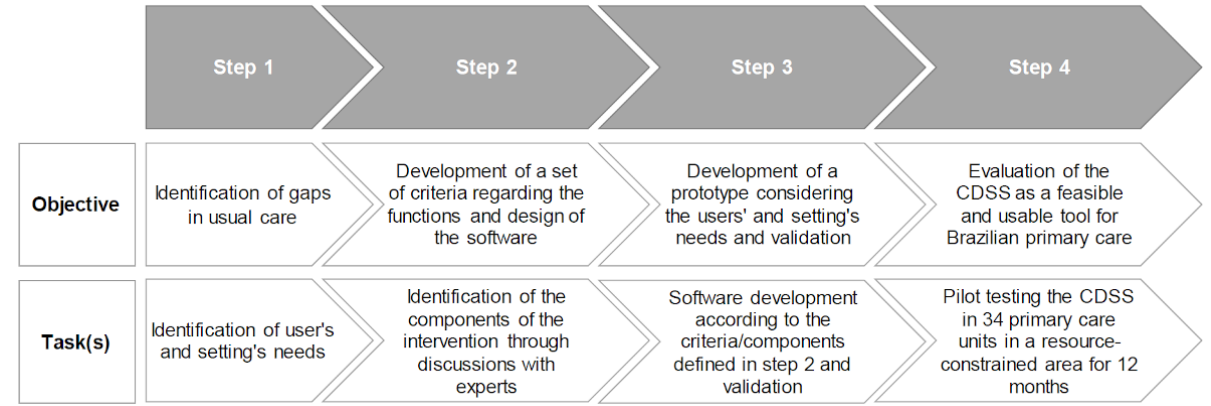
Figure 1. Flowchart of the study methodology. CDSS: clinical decision support